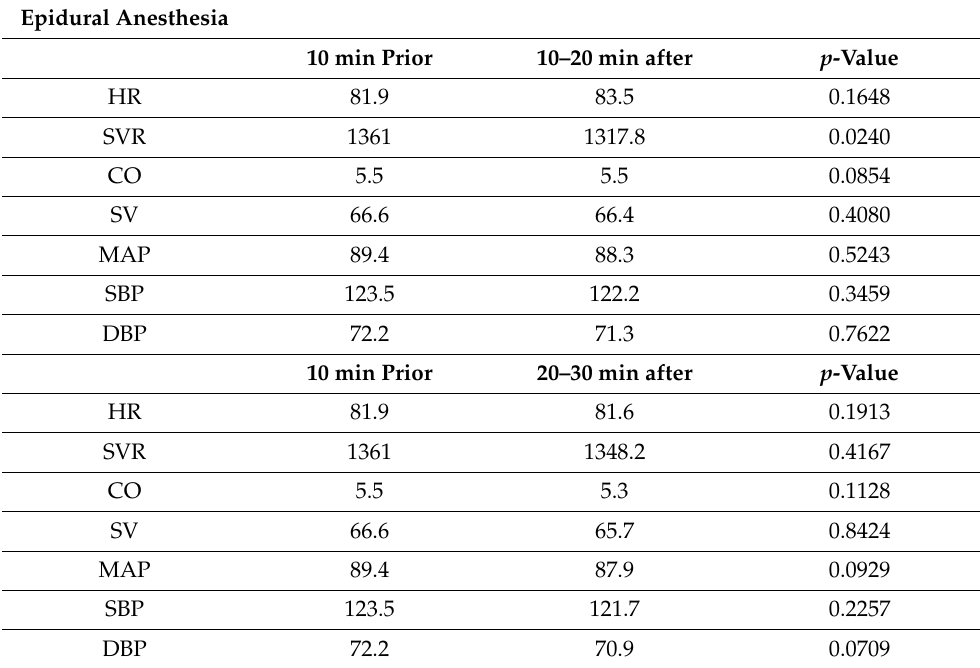
Table 3. Trends in vital signs 20 and 30 min before and after epidural anesthesia.